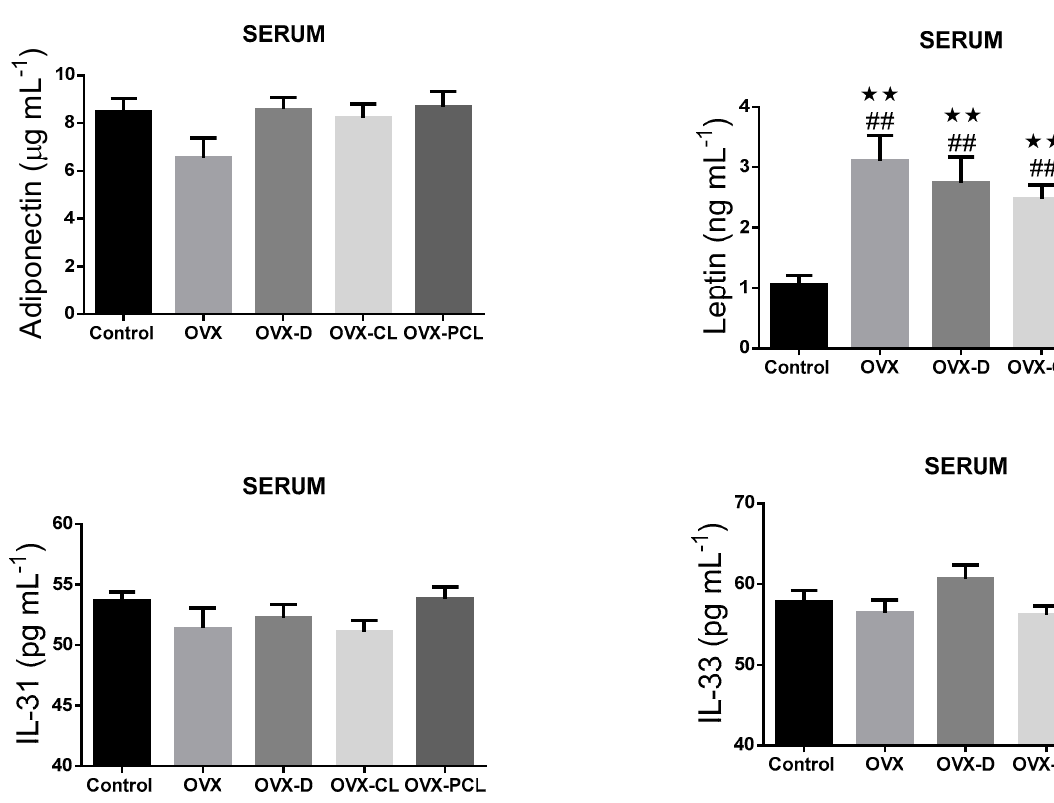
Figure 1. The levels of adipokines and cytokines in the serum of rats. OVX: ovariectomized group; OVX-D: ovariectomized group with a deprivation of calcium; OVX-CL: ovariectomized group with a deprivation of calcium with the addition of calcium lactate; OVX-PCL: ovariectomized group with a deprivation of calcium with the addition of pumpkin enriched with calcium lactate. IL-31: interleukin 31; IL-33: interleukin 33; statistically significant changes are marked ** p < 0.01 compared to control and ## p < 0.01 compared to OVX-PCL.